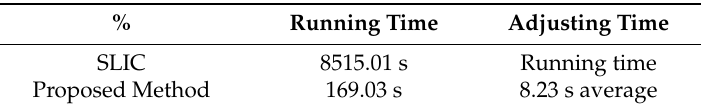
Table 3. Comparison of the running time and adjusting time between simple linear iterative clustering (SLIC) and the proposed method presented in Table 3. The cost time is based on the whole polarimetric SAR image with 4500 × 3000 pixels.